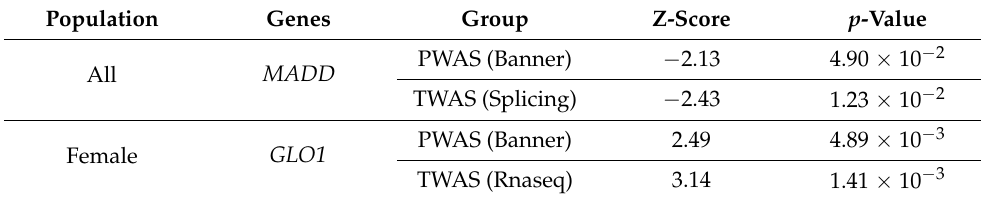
Table 3. Comparative results of the PWAS and TWAS analyses in different populations. Population Genes Group Z-Score p -Value All MADD